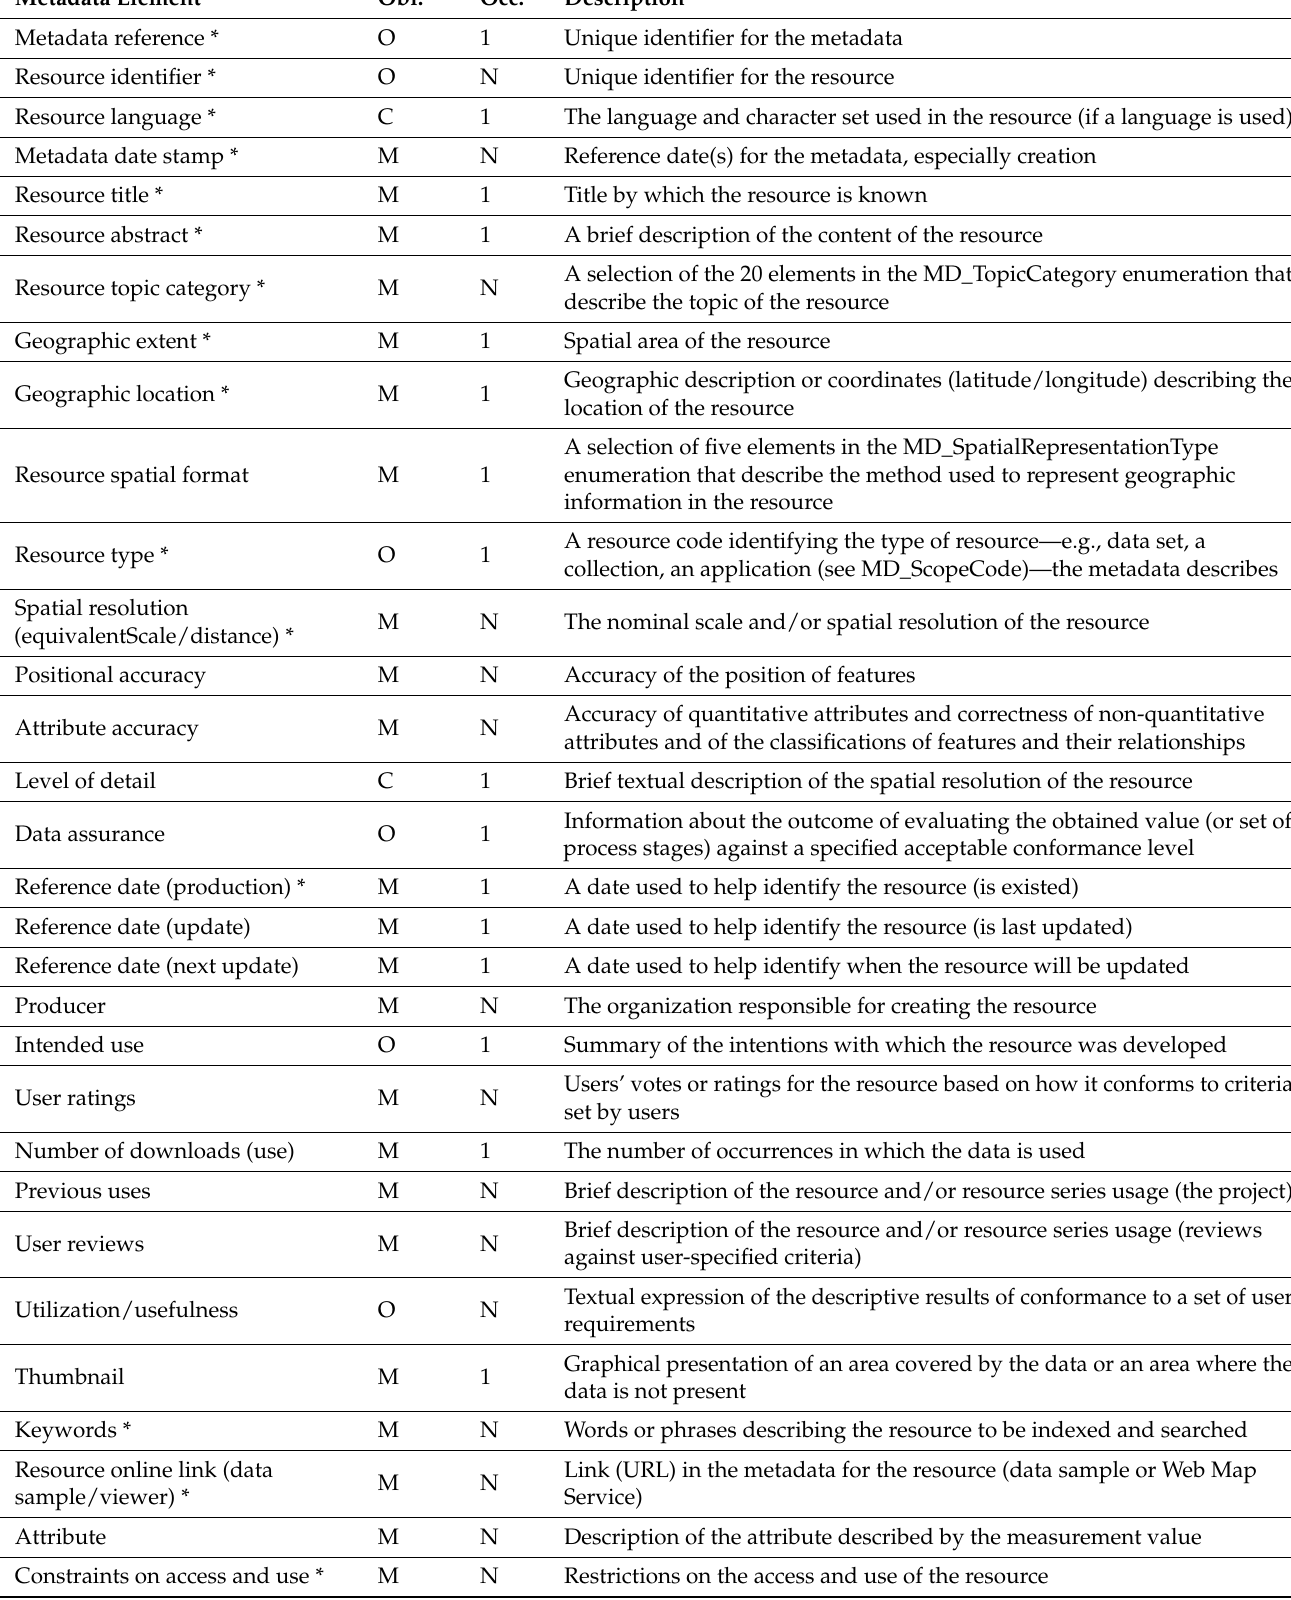
Table 20. User-oriented spatial metadata